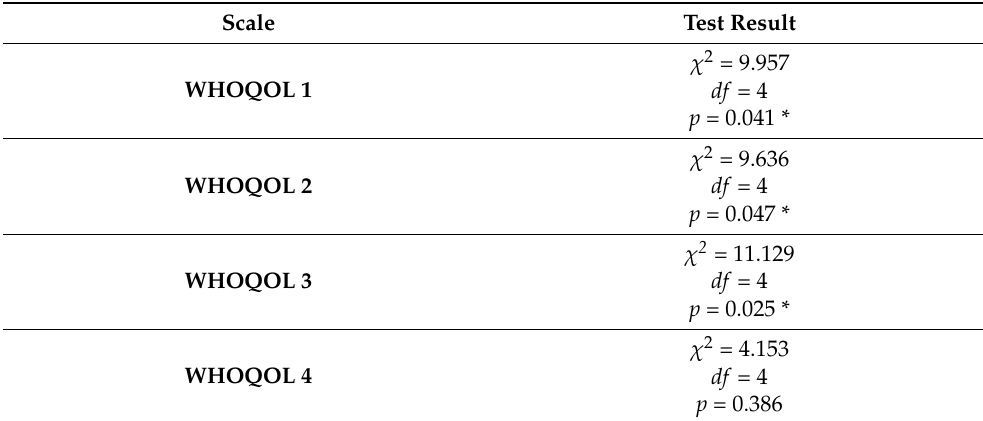
Table 4. Comparative characteristics of quality-of-life levels in several domains of groups with varying yoga practice experience. Scale Test Result WHOQOL 1